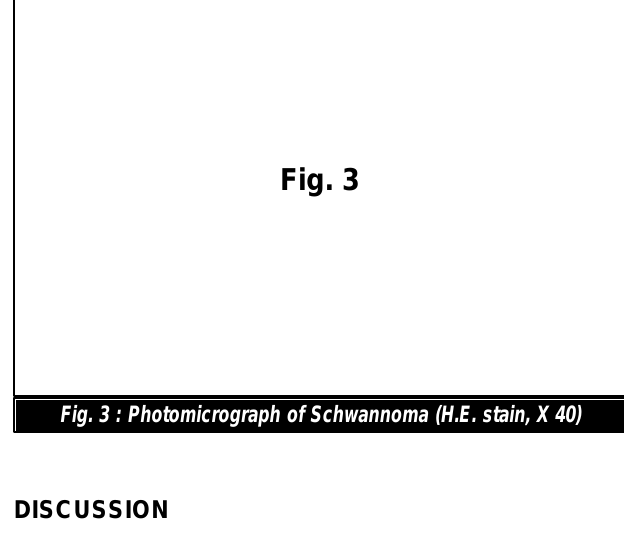
Fig. 3 : Photomicrograph of Schwannoma (H.E. stain, X 40) Fig. 1